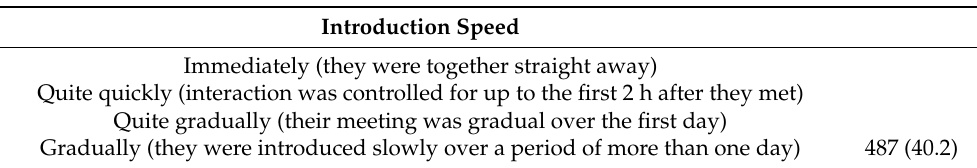
Table 2. List of responses available to owners to describe the speed of introducing their puppy to existing household